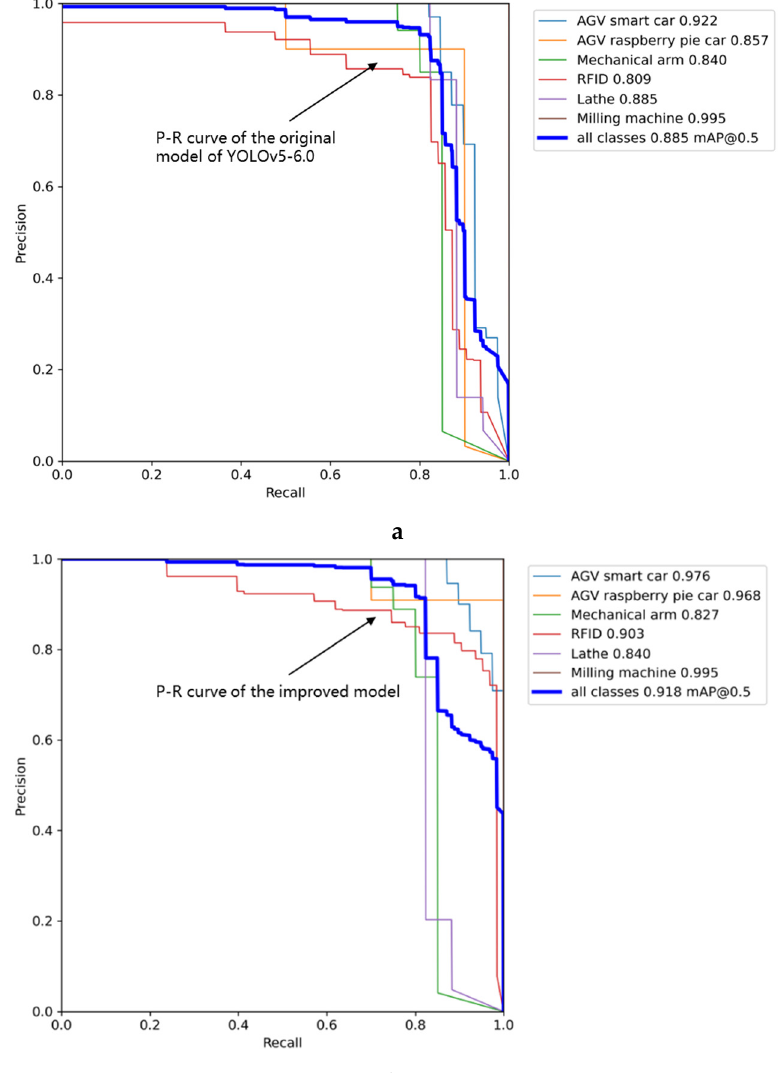
Figure 9. Comparison of performance parameters of YOLOv3, YOLOv5-6.0, YOLOv5-5.0, YOLOv5- Lite, and improved method iteration process.